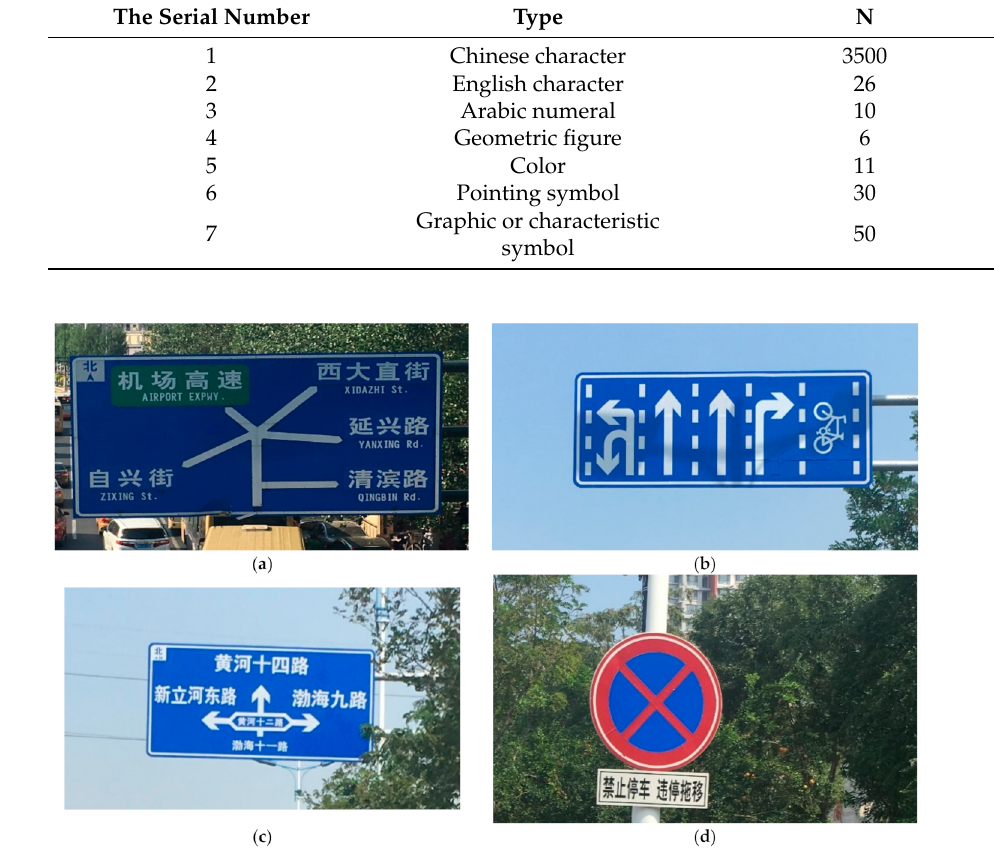
Figure 3. Examples of information elements contained in urban road traffic signs. ( a ) Traffic sign 1. ( b ) Traffic sign 2. ( c ) Traffic sign 3. ( d ) Traffic sign